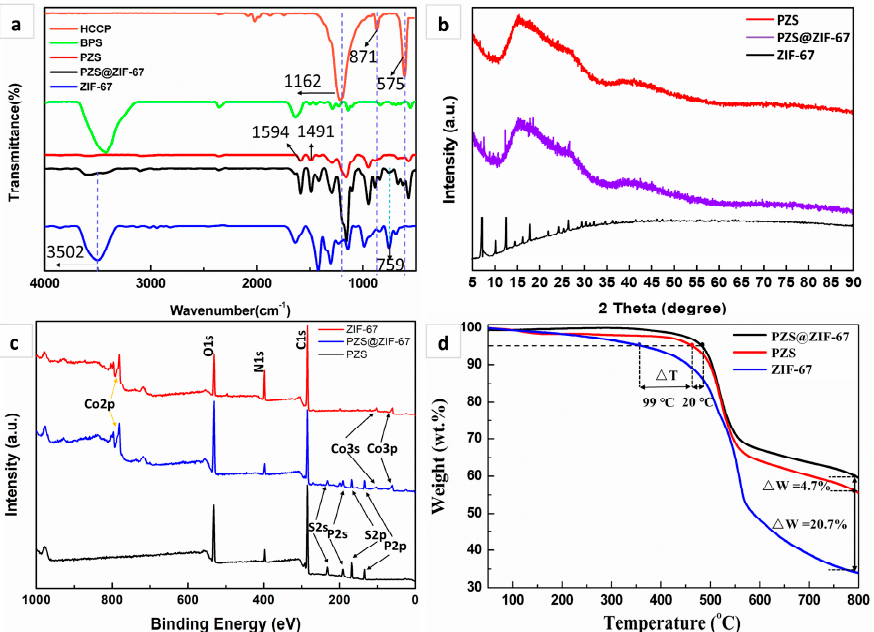
Figure 4. ( a ) FTIR spectra; ( b ) Wide-angle XRD patterns; ( c ) XPS survey spectra; ( d ) TGA curves of ZIF-67, PZS, and PZS@ZIF-67.